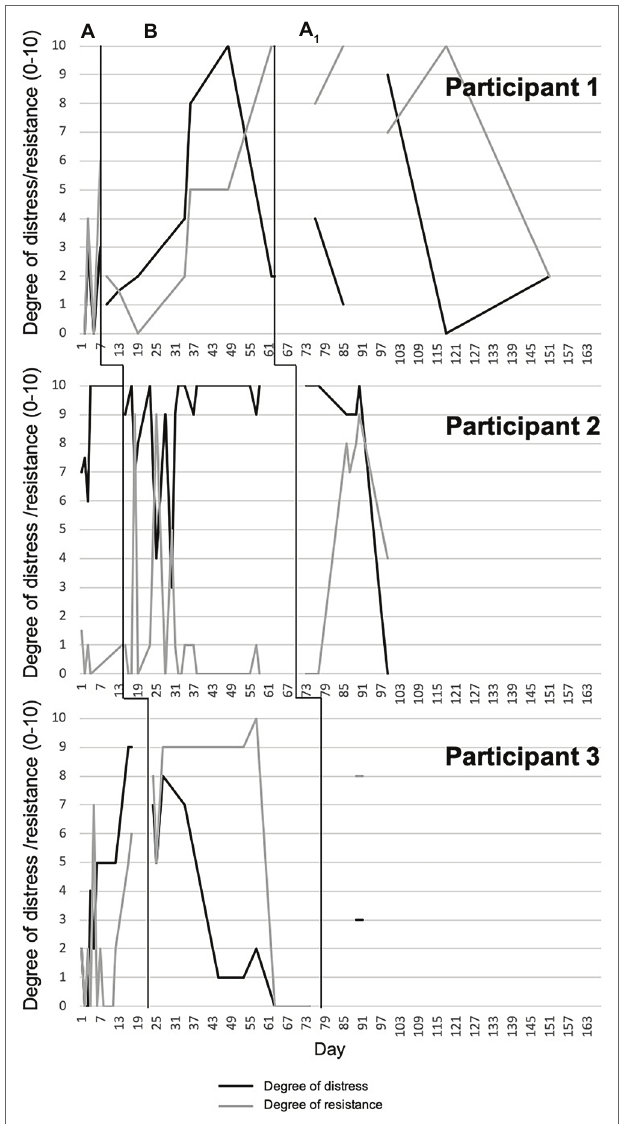
FIGURE 2 | Degree of resistance to pulling urges and degree of associated distress over time